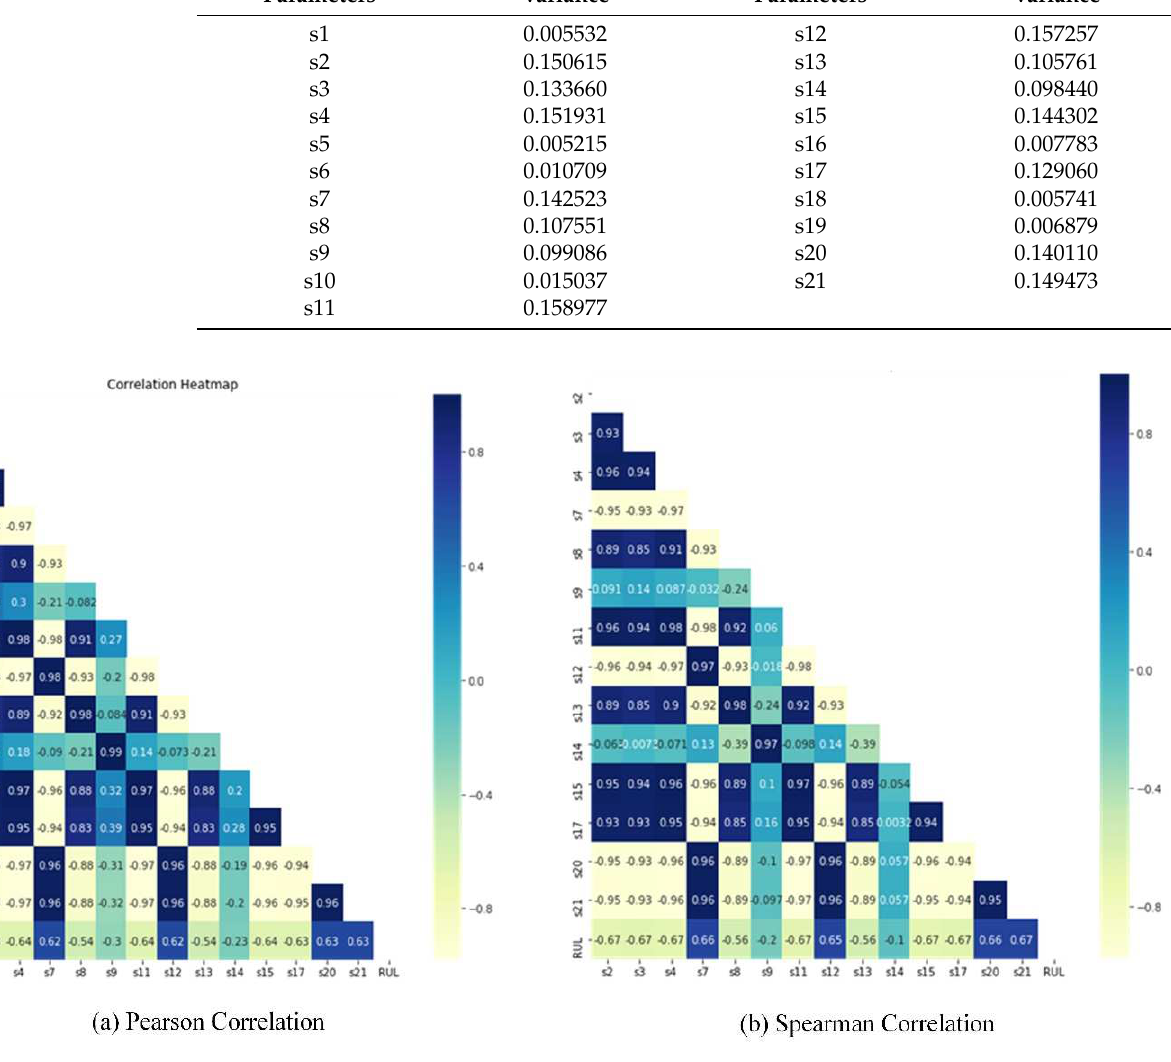
Figure 8. Correlation coefficient analysis.